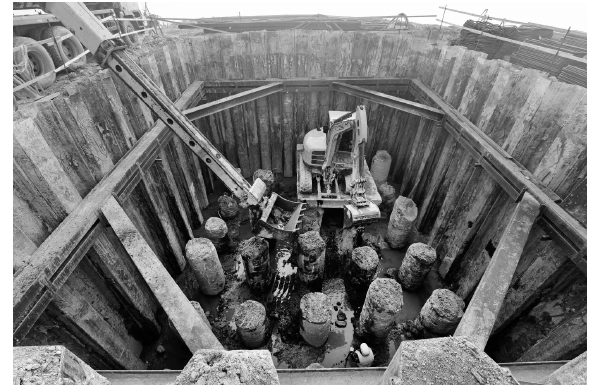
Figure 3. Exposed piles in a sheet pile sump